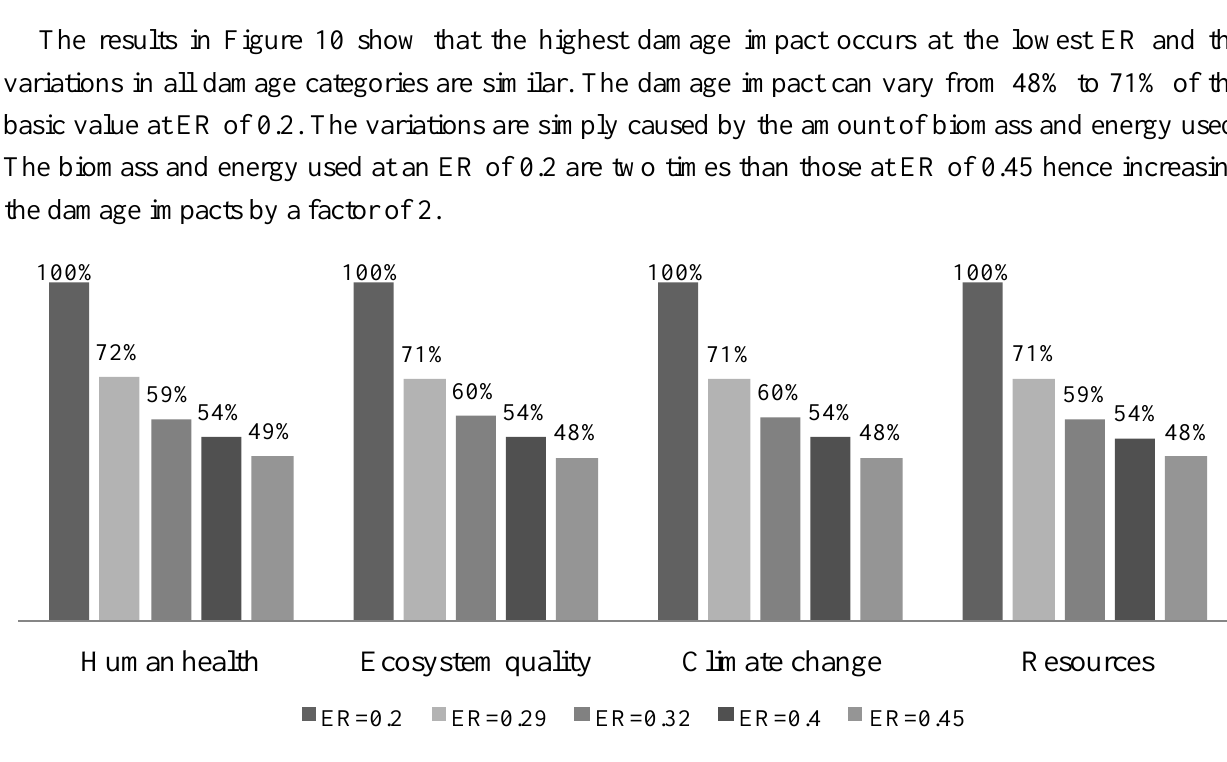
Figure 10. Damage assessment of producing syngas with various